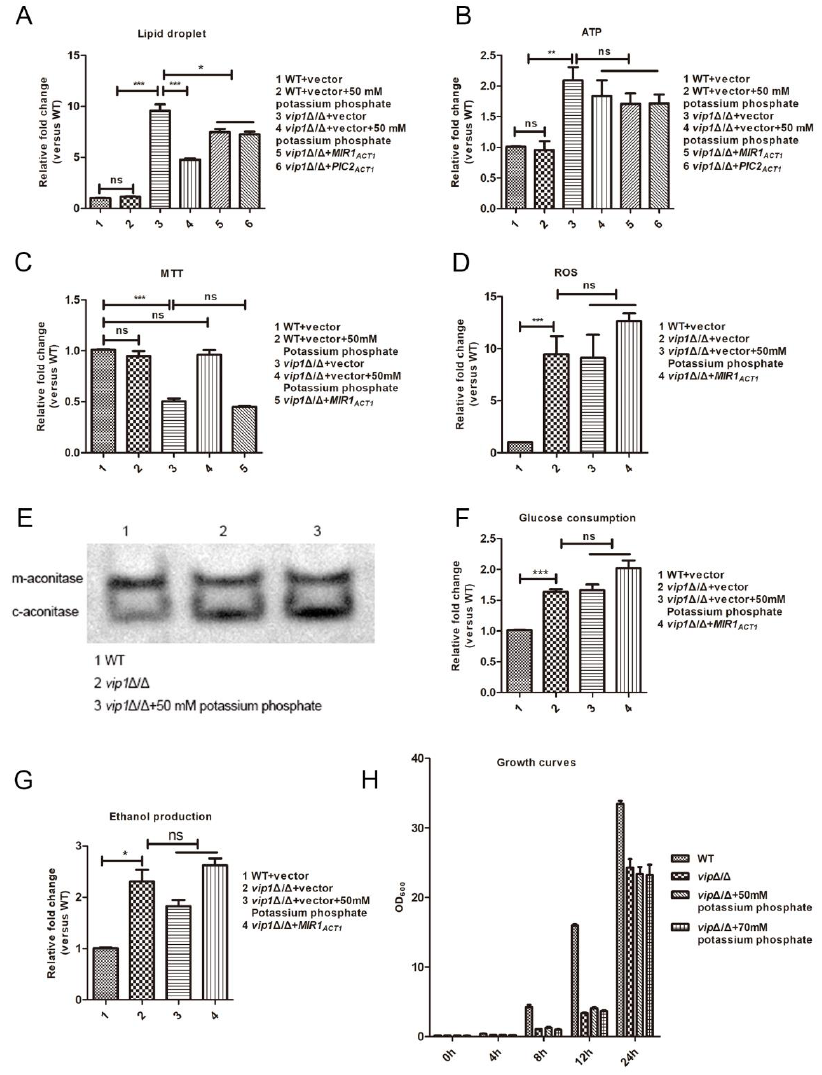
Figure 1. Pi cannot affect the energy balance of vip1 Δ/Δ . ( A ) Determination of LDs. Strains were grown in SC or SC medium with Pi to stationary phase, and the cells were collected stained with Nile red, and the fluorescence intensity was measured with a microplate reader (Perkin Elmer, Waltham, MA, USA). ( B ) ATP content determination. Collected strains were grown in SC or SC medium with Pi to determine ATP content. ( C ) MTT assay for measuring mitochondrial succinate dehydrogenase activity of strains grown in SC or SC medium with Pi. ( D ) ROS determination. The strains were grown in SC or SC medium with Pi. The ROS content of the strains was stained with DCFH-DA, and the fluorescence intensity was measured with a microplate reader (Perkin Elmer, USA). ( E ) Mitochondrial aconitase activity was measured using the IGA method. The strains were grown in SC or SC medium with Pi. Strains were collected and glass beads were added, followed by vortexing to break the strain and then centrifugation to collect the supernatant for aconitase activity determination. ( F ) Glucose consumption rate. ( G ) Ethanol production. ( F , G ) After growing the strain in SC or SC medium with Pi, the mid-log phase strains were collected and centrifuged, and the supernatant was used for the determination of glucose and ethanol content. ( H ) Growth curve. Strains were grown in SC or SC medium supplemented with Pi, and the OD 600 was measured at 4, 8, 12 and 24 h. * p < 0.05, ** p < 0.01, *** p < 0.001, ns: no significance. Pi is an important nutrient that regulates glycolysis and mitochondrial metabolism